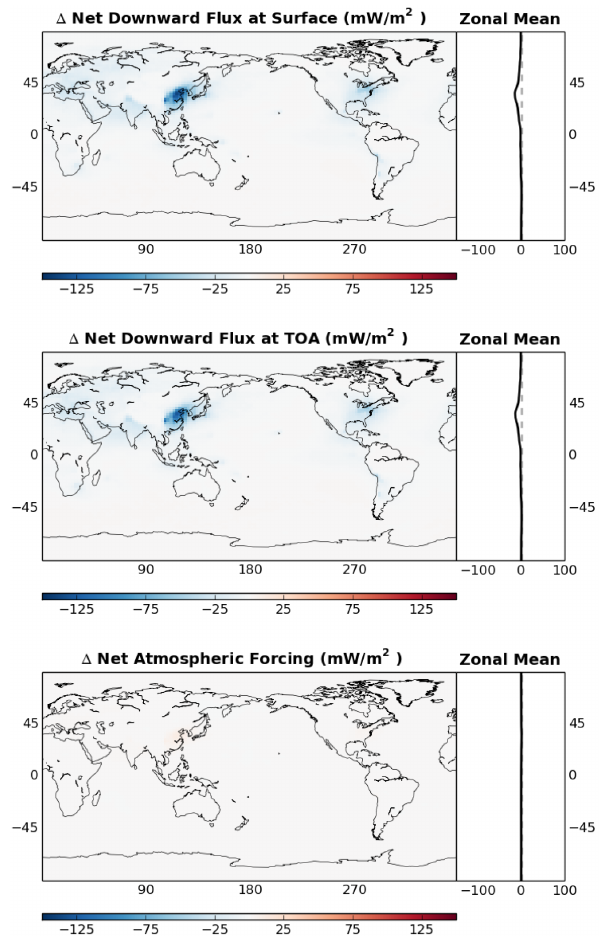
Figure 4. Annual averaged instantaneous radiative forcing, in mWm − 2 , at the surface (top) and top of model (middle) for sul- fate aerosols. Net downward atmospheric forcing is shown in the bottom plot for sulfate aerosols. Unlike the chemical mechanism evaluation, this simulation spanned a full year to enable an annual averaged